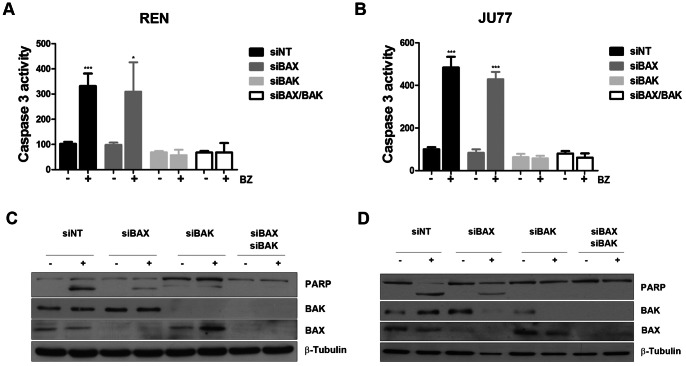
In MPM cell lines, dowregulation of BAK induces resistance to bortezomib-induced apoptosis.A) REN and B) JU77 cells were transfected with siNT, siBAX, siBAK and the combination of siBAX and siBAK. 24 h following transfection, cells were treated with a concentration of bortezomib equal to the IC50 calculated for each cell line and caspase3 activity measured. Data were normalized to NT untreated control (REN: siNT p = 0.0003 siBAX p = 0.0159; siBAK n.s. siBAXsiBAK n.s.; JU77: siNT p = 0.0002 siBAX p = 0.0002; siBAK n.s.; siBAXsiBAK n.s.). C) BAX and BAK expression and PARP cleavage were confirmed by western blot analysis in REN and D) JU77 cells.